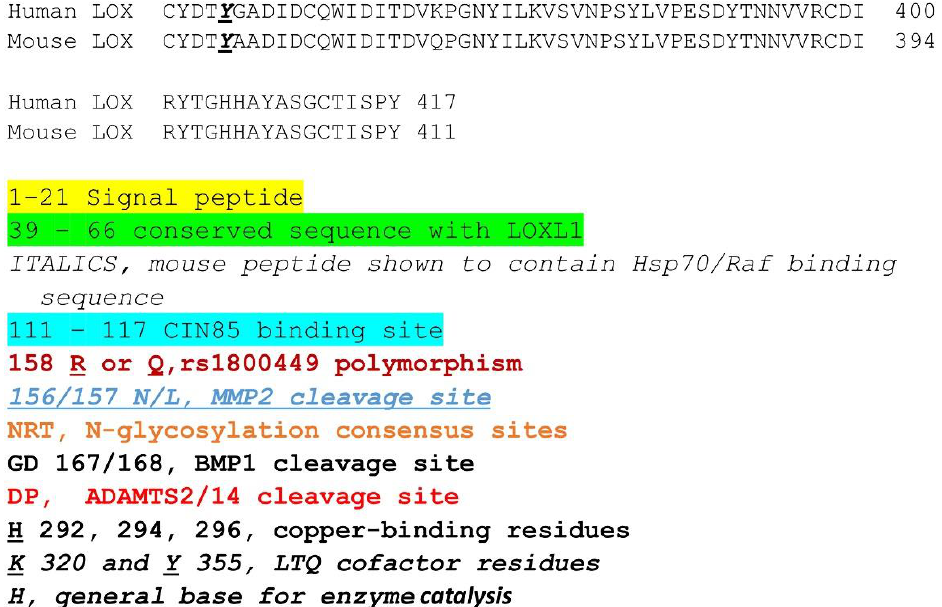
Figure 2. Aligned amino sequences of human and mouse pro-LOX, processing sites, active domains, and binding sequences. Symbols and colors are defined at the bottom of the figure and identify the sequences described in the text.